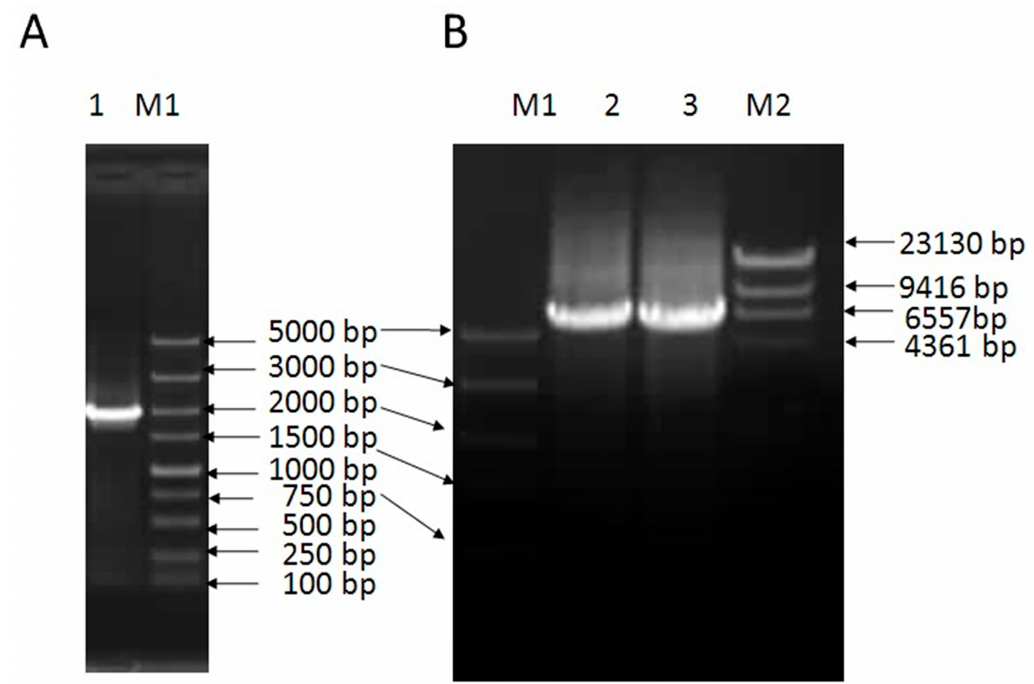
Figure 1. Cloning of VpSBP16 from V . pesudoreticulata . ( A ) PCR amplification of the full-length VpSBP16 cDNA and ( B ) DNA from Vitis pseudoreticulata . M1: DNA marker DL5000; M2: DNA marker λ -Hind III; 1: VpSBP16 PCR product from cDNA; 2 and 3: VpSBP16 PCR product.